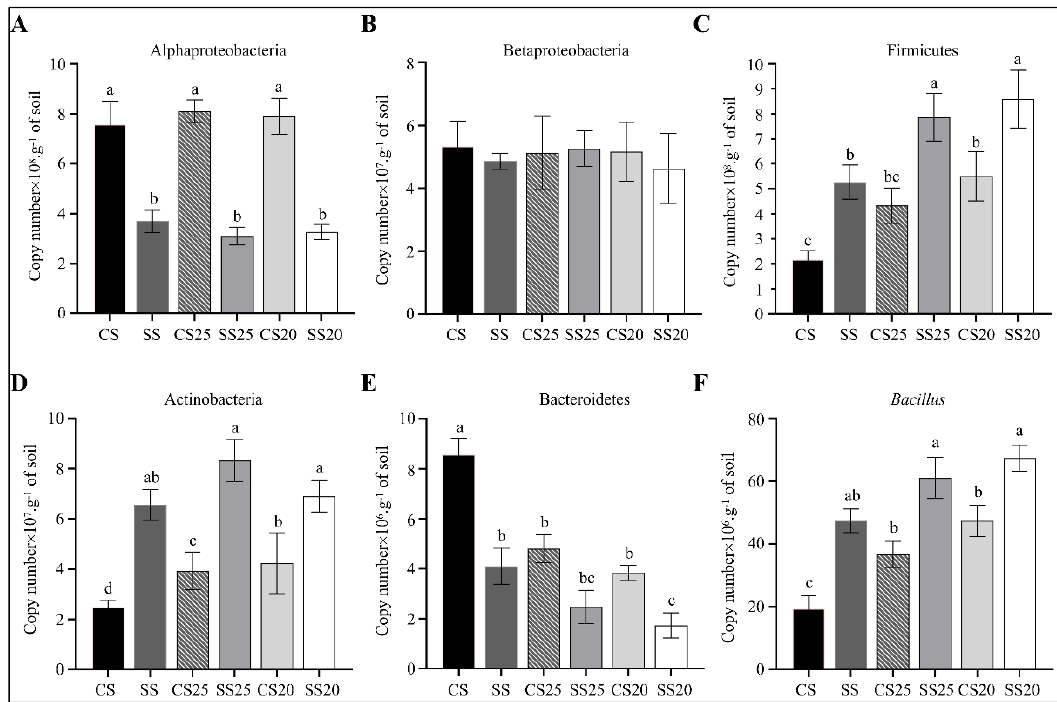
Figure 8. Quantification of predominant phyla or genera in the peanut spermosphere soils and the bulk soils. Quantification of ( A ) Alphaproteobacteria, ( B ) Betaproteobacteria, ( C ) Firmicutes, ( D ) Actinobacteria, ( E ) Bacteroidetes, and ( F ) Bacillus in various peanut spermosphere soils and bulk soils. Error bars indicate the SEM ( n = 3). One-way ANOVA Duncan’s test. Di ff erent lowercase letters represent di ff erent